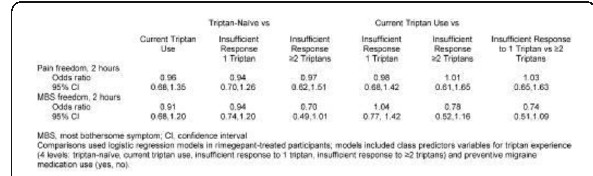
Fig. 2 (abstract P115). Coprimary Efficacy Endpoints Compared Pairwise between Triptan Experience Subgroups Using Logistic Regression Models in Rimegepant-Treated Subjects